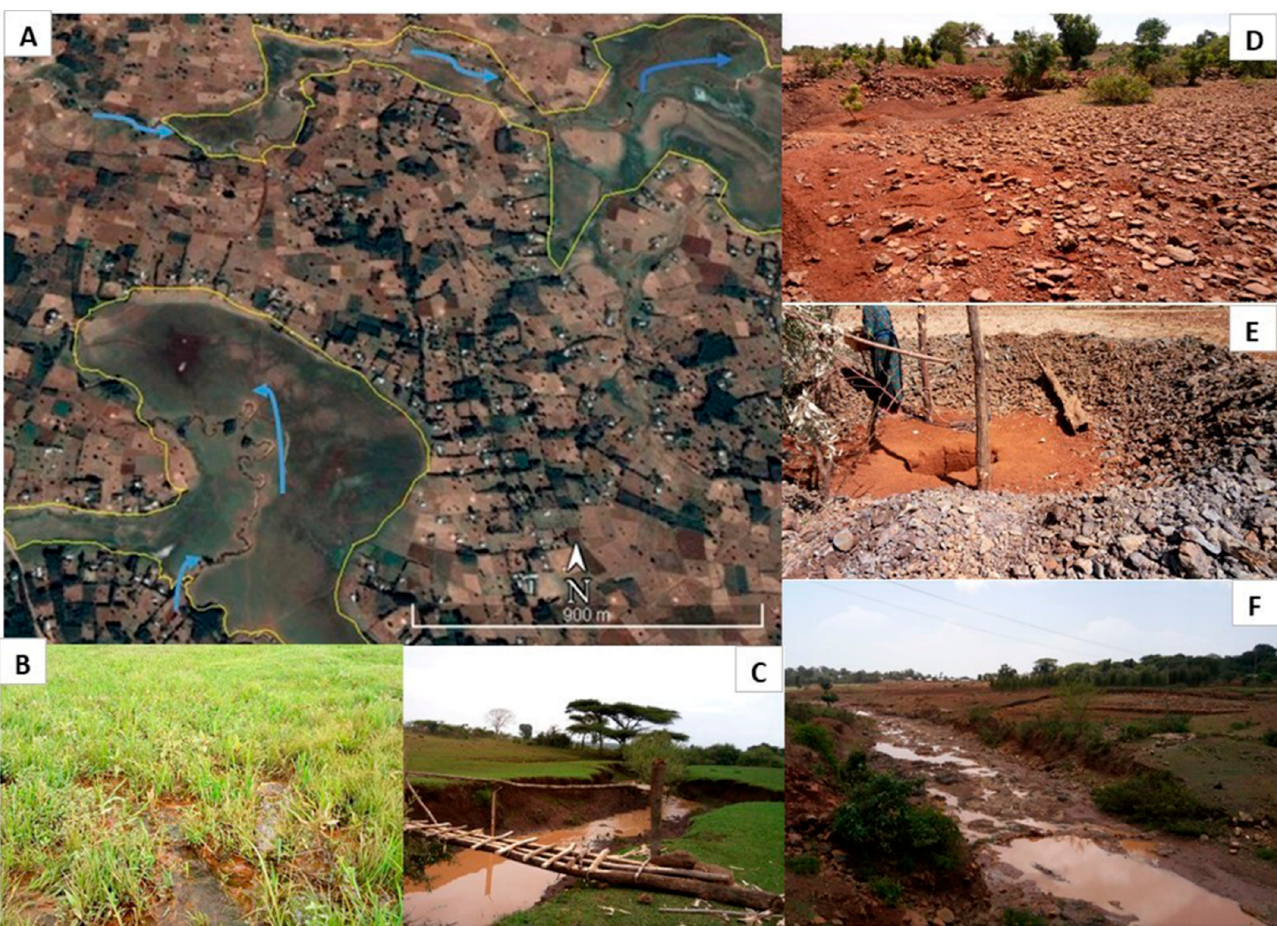
Figure 2. Maps and photos depicting features in the Dangishta and Robit Bata watersheds: ( A ) map of Dangishta showing seasonally saturated floodplain (taken from Google Earth image on 6 June 2018); yellow line is the boundary of the floodplain, and arrows indicate surface water flow directions; ( B ) photo taken in the rain phase of 2021 that shows subsurface flow is surfaced and appears as springs in a floodplain in Dangishta; ( C ) riverbank in Dangishta shows that the valley bottom has deep soils (except for areas with volcanic dikes); ( D ) a thin weathered topsoil with gravel at steeply sloping areas in Robit Bata; ( E ) excavated well materials from a 12 m deep hand-dug well; and ( F ) photograph of bedrock geology with visible outcrops in riverbeds of Robit Bata. ( C – E ) were photographed in 2018 and ( F ) in 2017.